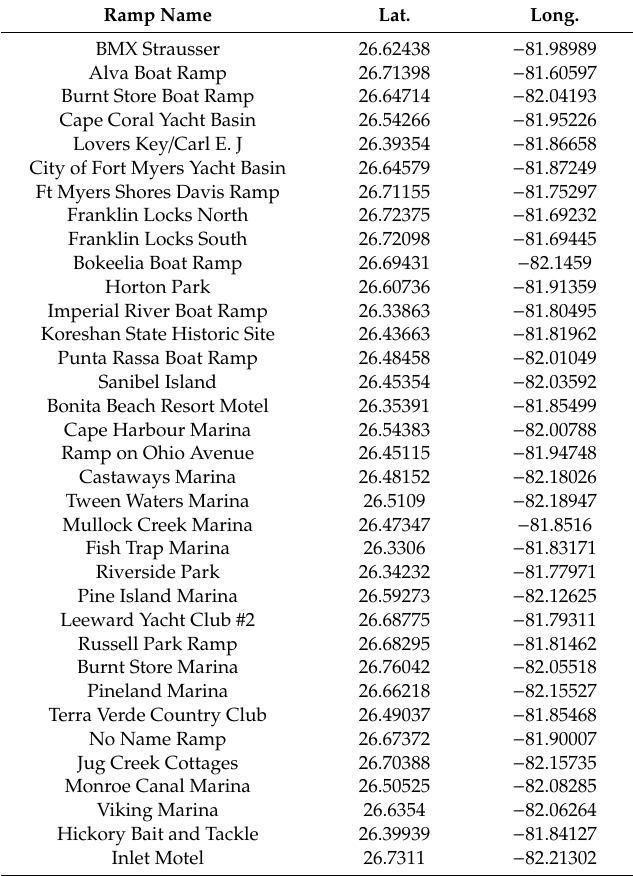
Table A1. Latitude and longitude coordinates of boat ramp groups in the